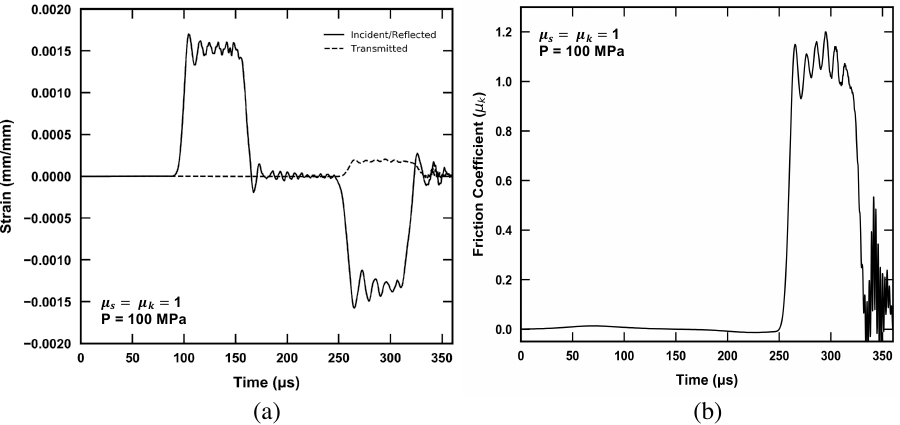
Fig. 4. (a) Simulation strain results for friction conditions µ k = µ s = 1 and a normal applied pressure of 100 MPa. (b) Corresponding friction coefficient calculated from the transmitted strain in